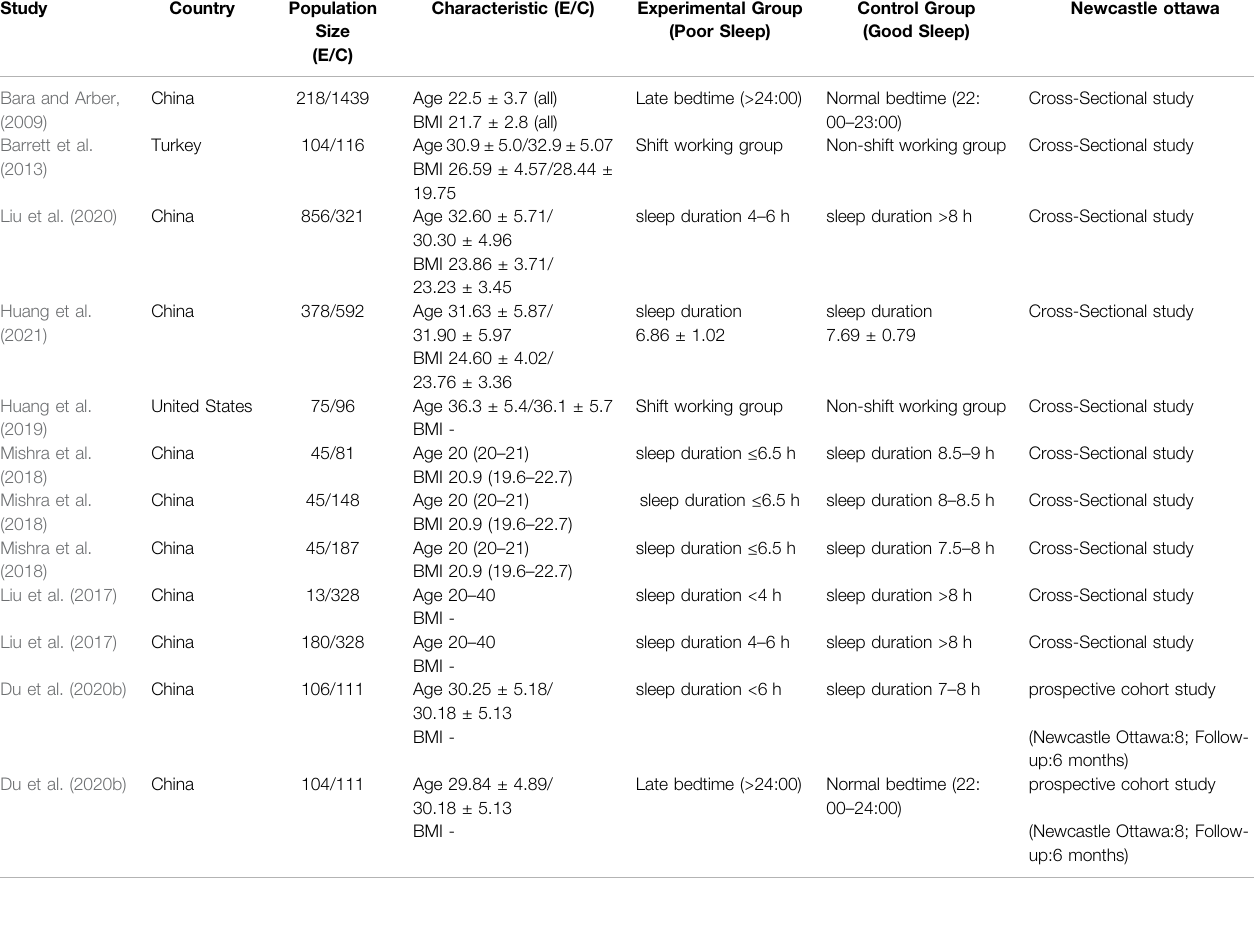
TABLE 1 | Characteristics of included studies.